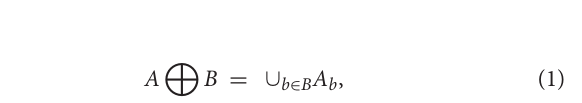
FIGURE 3 | Saved time for diagnosing the entire case against the number of tumorous